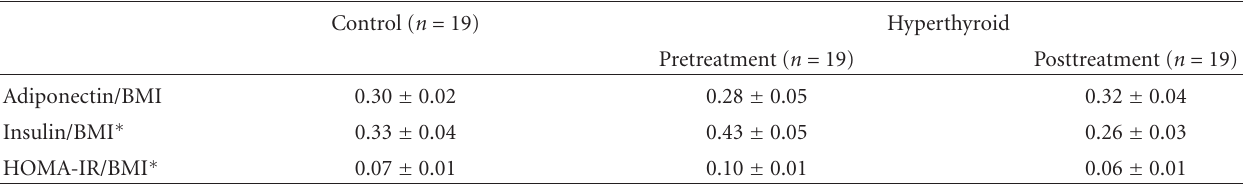
Table 2: Comparisons of BMI-adjusted plasma adiponectin concentration, insulin concentration, and HOMA-IR value among the control and hyperthyroid groups before and after treatment.